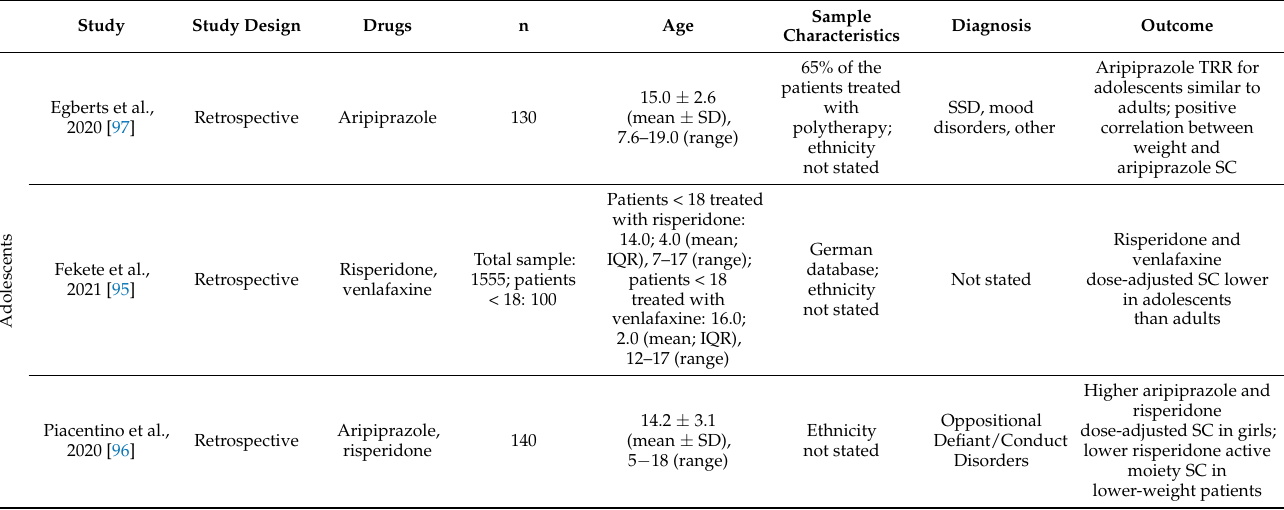
Table 6. Original articles on the use of TDM in adolescents and elderly